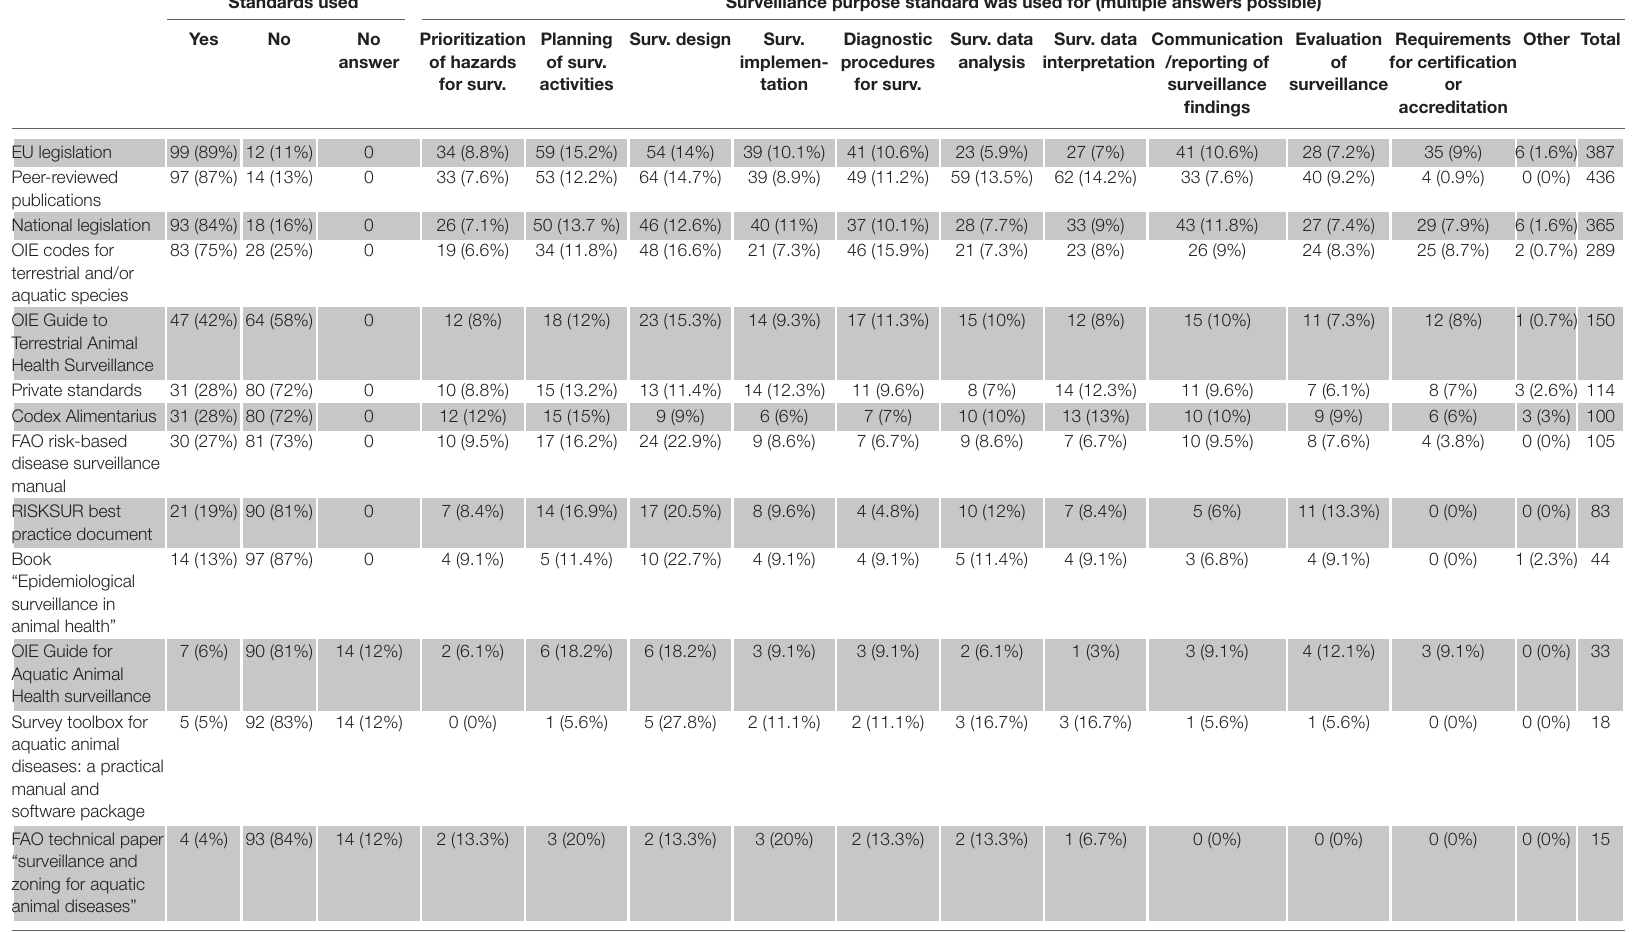
TABLE 1 | Surveillance standards used by respondents and surveillance purpose the standards were used for. Standards